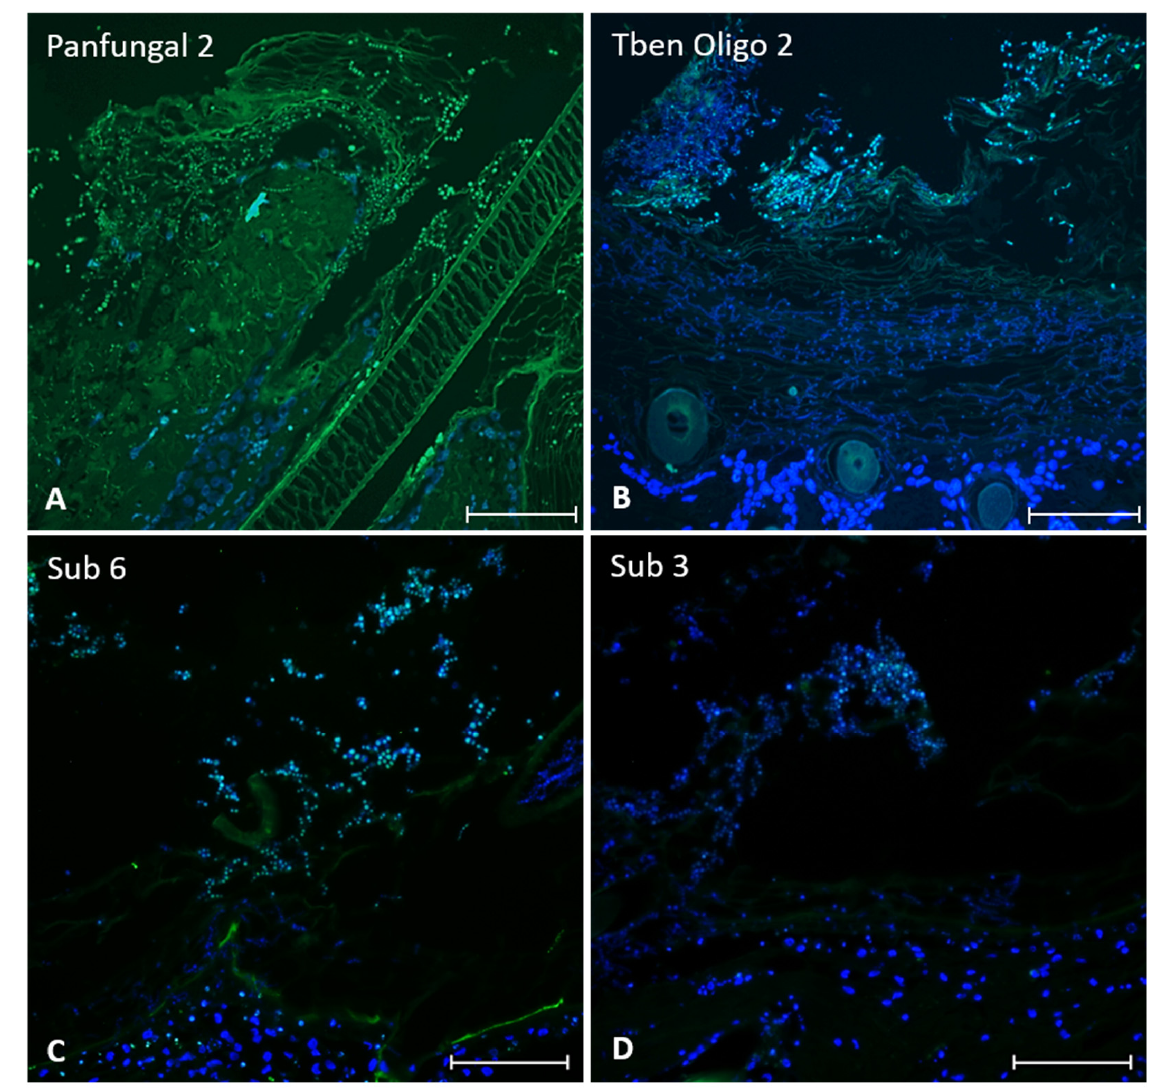
Figure 2. FISH in T. benhamiae infected GPSE. ( A ) T. benhamiae infected GPSE were incubated with the “Panfungal 2” probe (shown in green); fungal elements in the stratum corneum , mainly conidia, are stained. In ( B ), the T. benhamiae specific probe “Oligo 2 (Tben)” clearly marks the conidia while hyphae infiltrating the stratum corneum and deeper skin layers show a less intense staining. In ( C ) and ( D ), the probes detecting the virulence factor transcripts sub 6 and 3 , respectively, mainly label conidia in superficial epidermal layers (all images: original magnifications 200×, bars = 100 µm; nuclear counterstain ensued with bisBenzimide Hoechst 33342 and is depicted in blue).